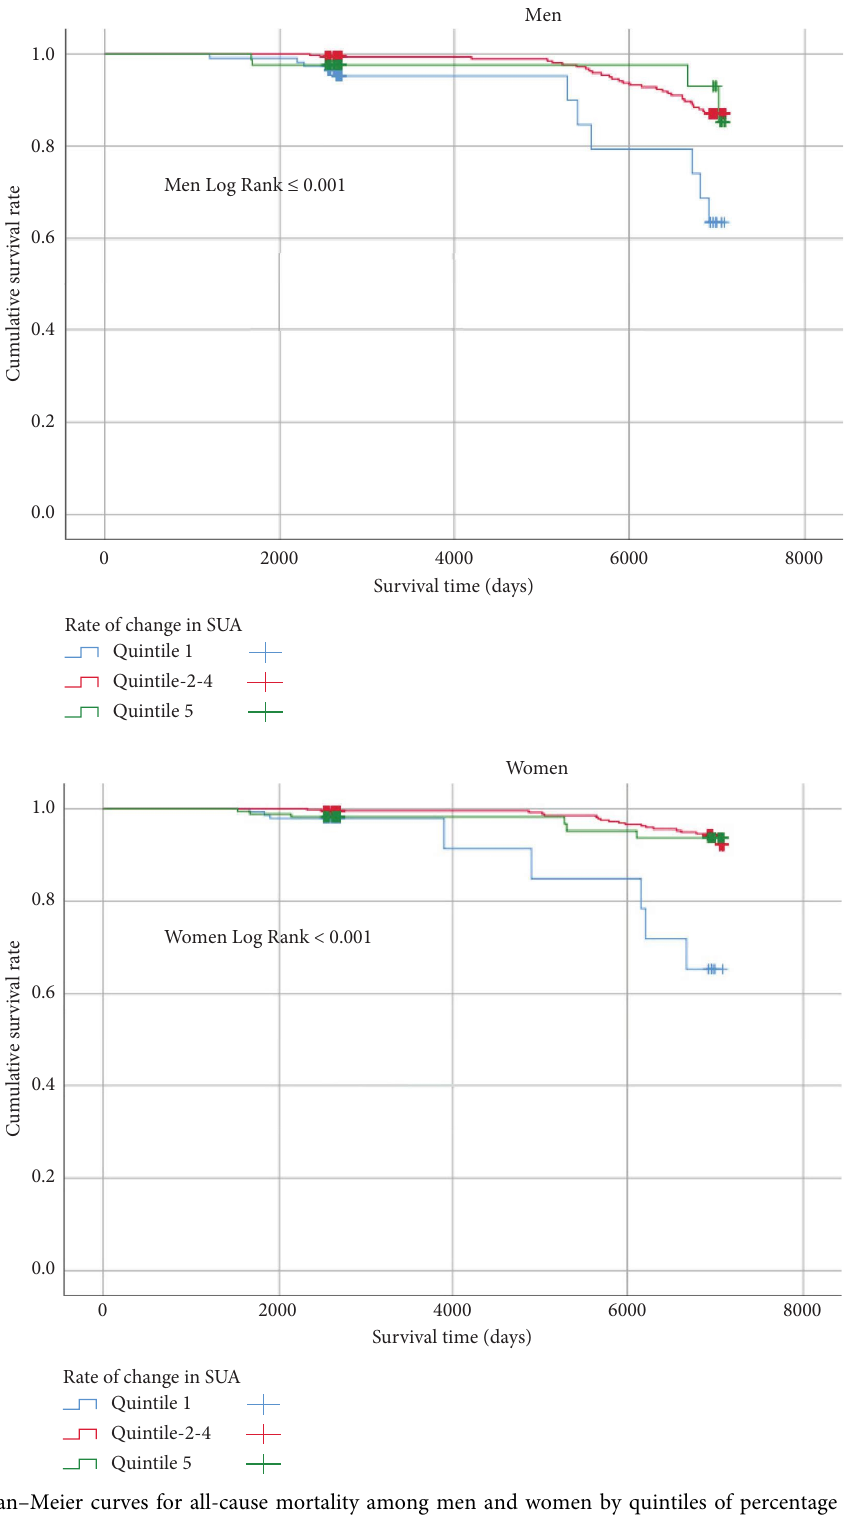
Figure 1: Kaplan–Meier curves for all-cause mortality among men and women by quintiles of percentage change in